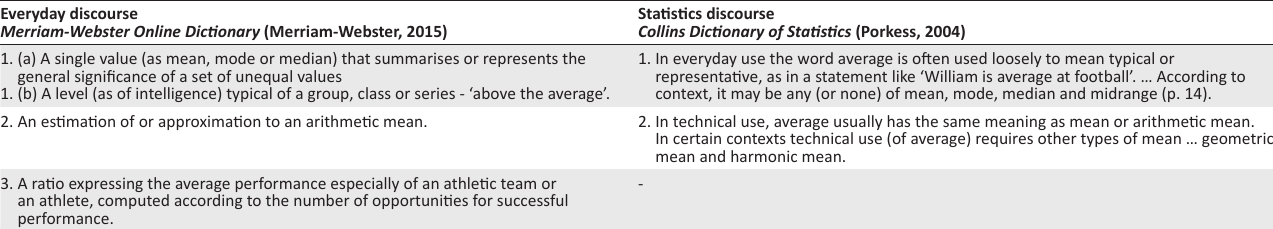
TABLE 1: Comparison of definitions of average in everyday and statistics